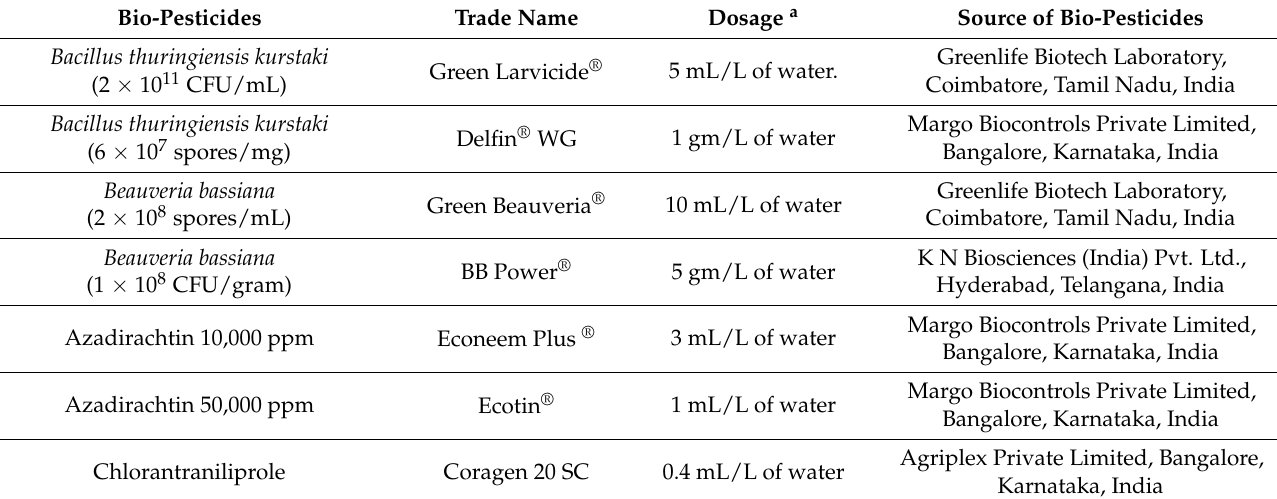
Table 1. List of bio-pesticides and chemical pesticide used against Tuta absoluta .